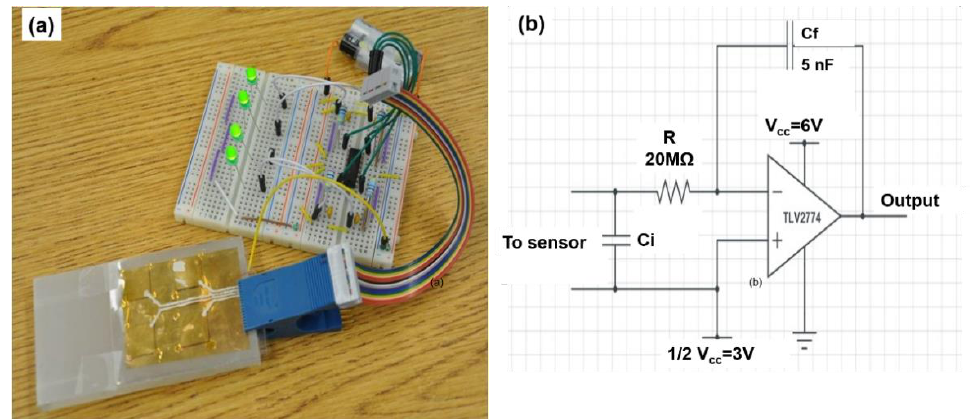
Figure 3. ( a ) Photo of a fabricated 2 × 2 micropillar-based COC piezoelectret sensor array with application for pressure mapping; ( b ) Piezoelectret pressure sensing circuit.